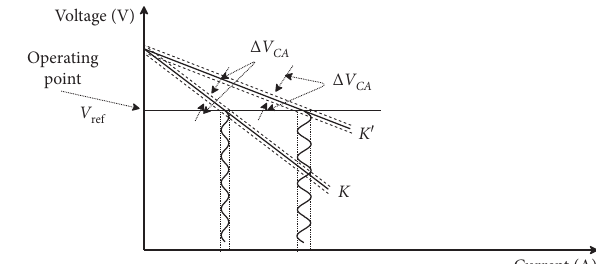
Figure 6: Oscillatory current around the desired operating point for two droop gains with K > K ′